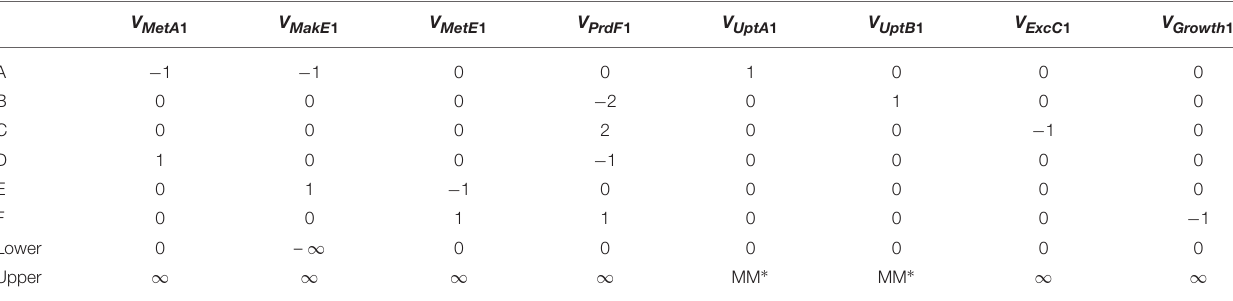
TABLE B1 | Stoichiometric Matrix (S) and lower and upper bounds for the FBA of species 1. V MetA